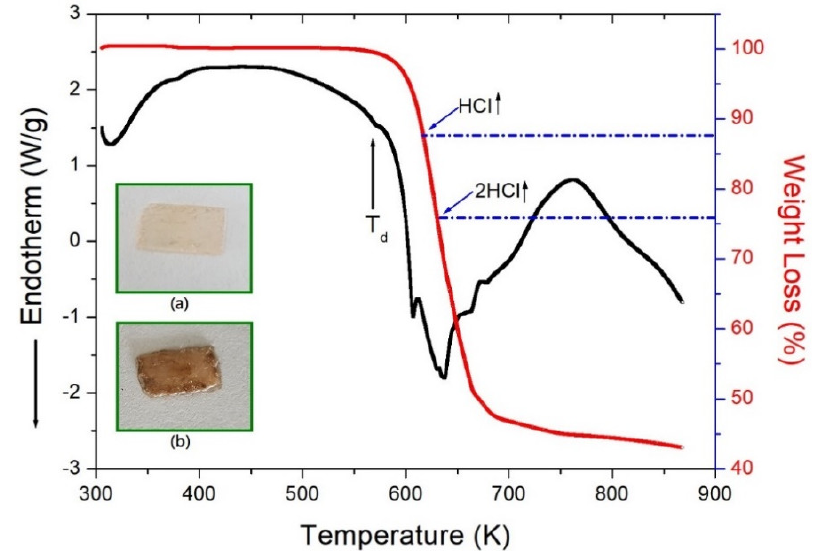
Figure 6. Thermogravimetric analysis and differential thermal analysis curves of [NH 3 (CH 2 ) 5 NH 3 ]MnCl 4 Thermogravimetric analysis and differential thermal analysis curves of (Inset: Changes in crystal by optical polarizing microscopy at ( a ) 300 K and ( b ) 617 K). [NH 3 (CH 2 ) 5 NH 3 ]MnCl 4 (Inset: Changes in crystal by optical polarizing microscopy at ( a ) 300 K